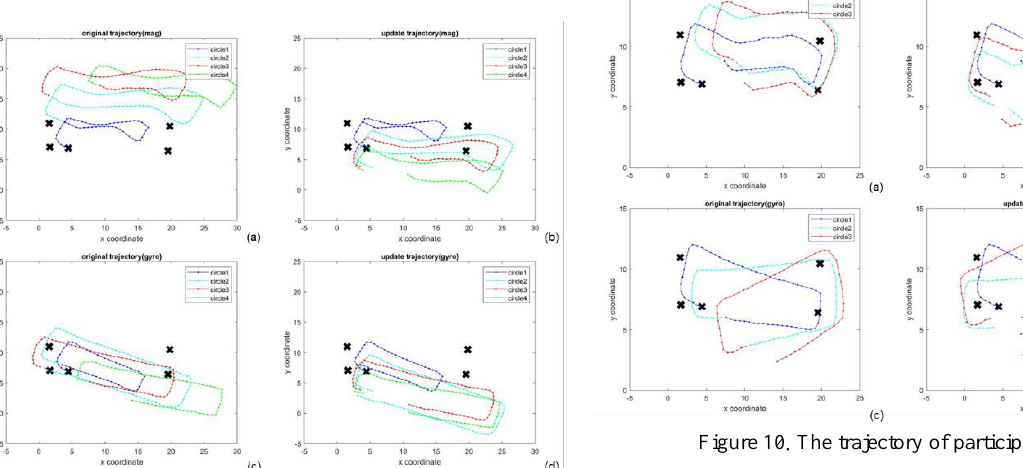
Figure 10 . The trajectory of participant 2